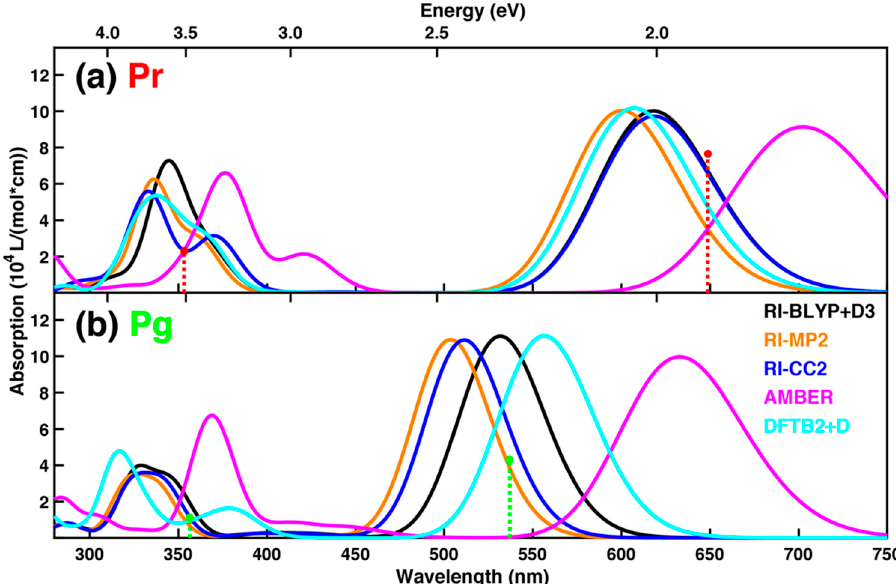
Figure 3. QM/MM absorption spectra for structures optimized at different levels of theory with QM66 for ( a ) the P r and ( b ) the P g form. The method for the treatment of the QM atoms is stated in the legend, while AMBER denotes pure force field calculations. Excitation energies are obtained using sTD-DFT calculations for QM106. The sticks represent the positions and relative intensities of the two lowest energy absorption maxima for each form extracted from the measured spectra [14].